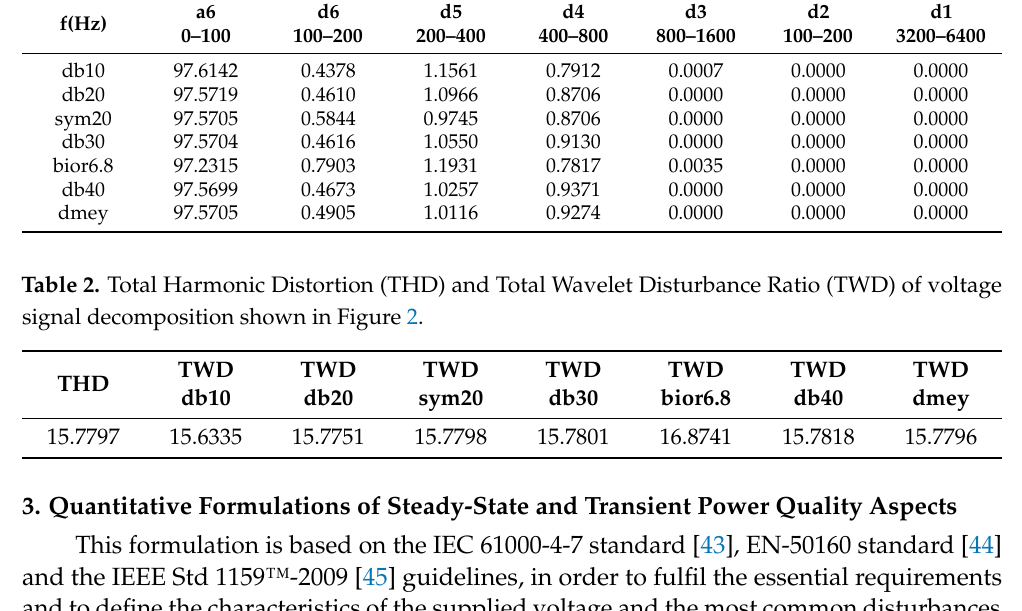
Figure 2. Voltage signal with harmonics: ( a ) Instantaneous representation, ( b ) FFT spectrum, ( c ) distribution of the energy percentage of the signal according to the coefficients of the mother wavelets. Table 1. Energies (%) of voltage signal decomposition shown in Figure 2.